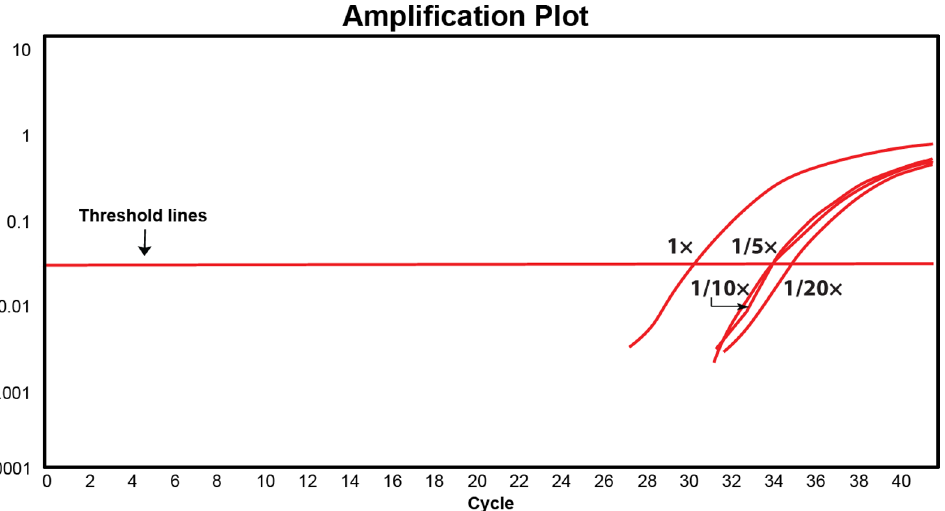
Fig. 5 is an example of a test showing one sample 167 (curves 1 and 2) and negative control (curves 3 and 4) using the nematode- universal primer/probe. The starting fluorescence of ROX in red (curves 2 and 3) were close to each other at ca 220,000, and the starting fluorescence of HEX in green (curves 1 and 4) was ca